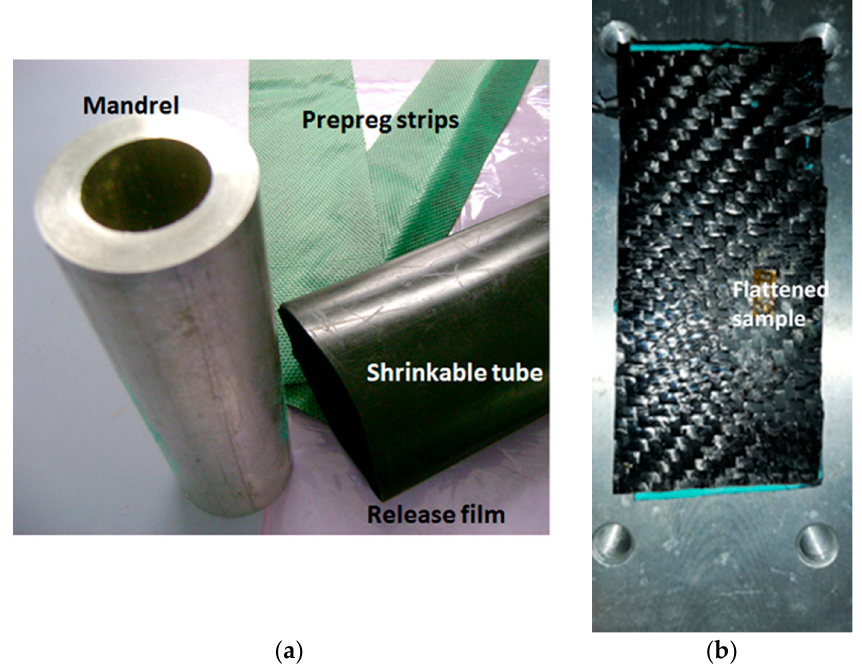
Figure 1. Elements for lab-scale manufacturing ( a ), and resulting Shape memory polymer composites (SMPC) parts ( b